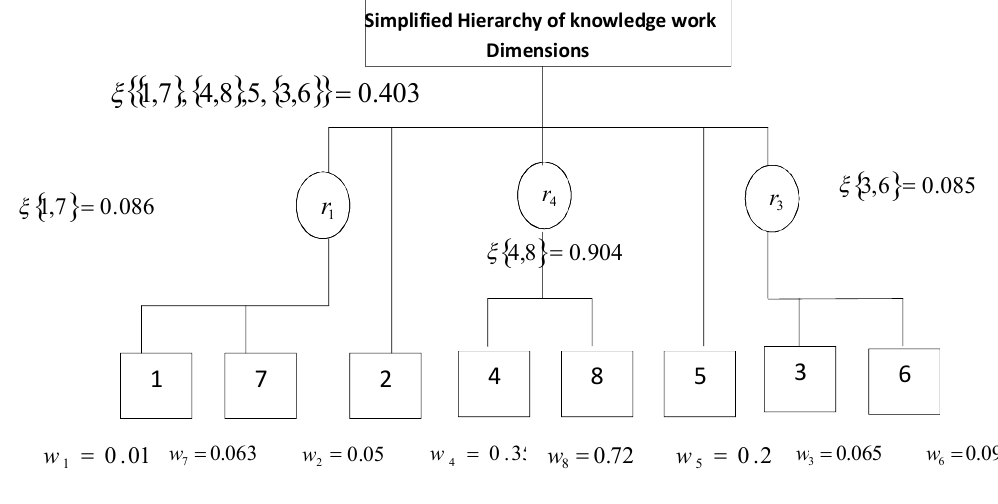
Fig. 7. Simplified identified hierarchy